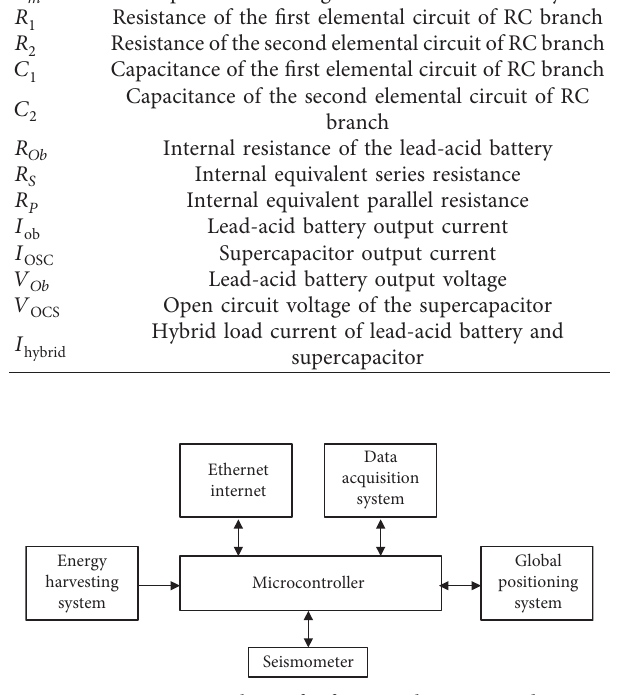
Figure 17: A plot of ambient temperature at the remote seismic